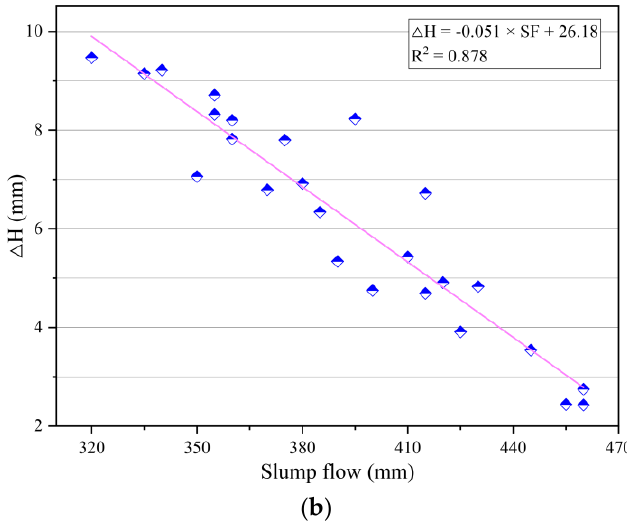
Figure 8. Correlation between thixotropy and flowability parameters of geopolymer composites. ( a ) Correlation between the cone depth H 1 and slump flow. ( b ) Correlation between the cone depth difference ∆ H and slump